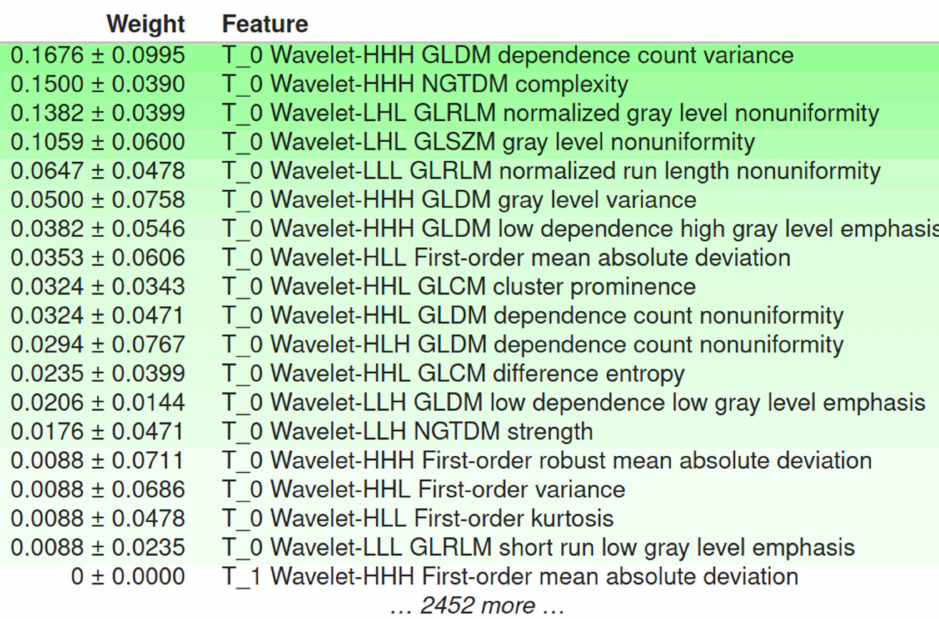
Figure 9. A top-down radiomics feature order in decreasing importance using local interpretable model-agnostic explanations (LIME). All radiomics features were shuffled individually and the permutation importance (reported as mean ± SD) was computed on the external validation